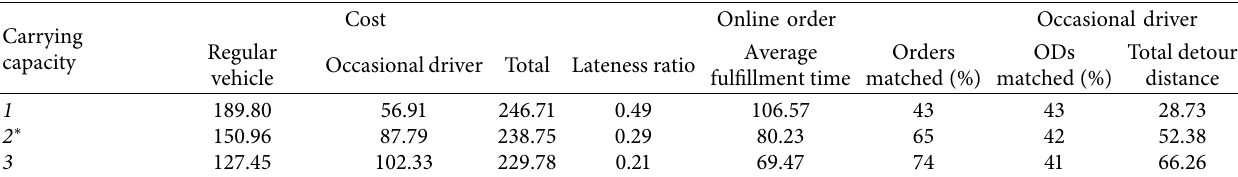
Table 5: Different OD carrying capacities.